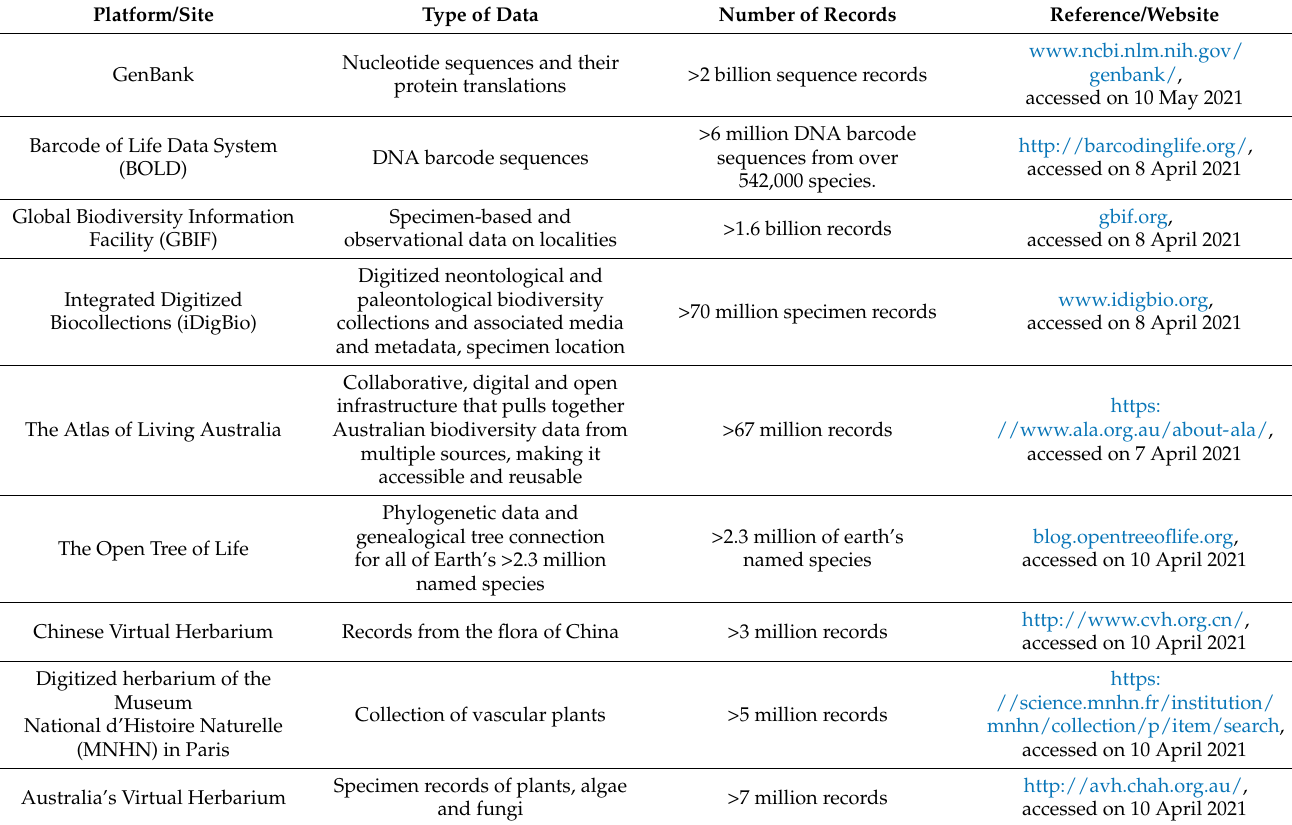
Table A1. Examples of notable biodiversity big data